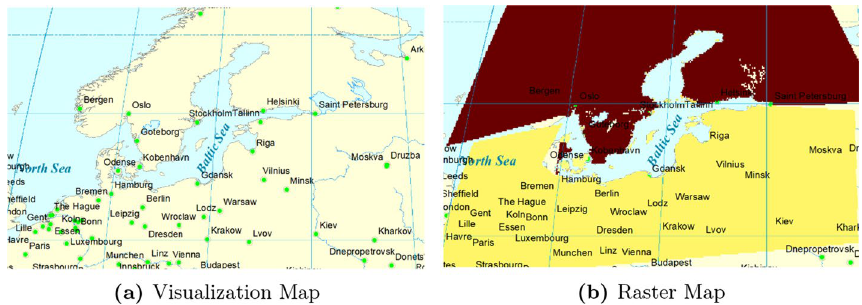
Fig. 3 Visualization map and raster map of the Baltic Sea geographic information.The rasterization method can represent geographic entities more effectively than the vector data